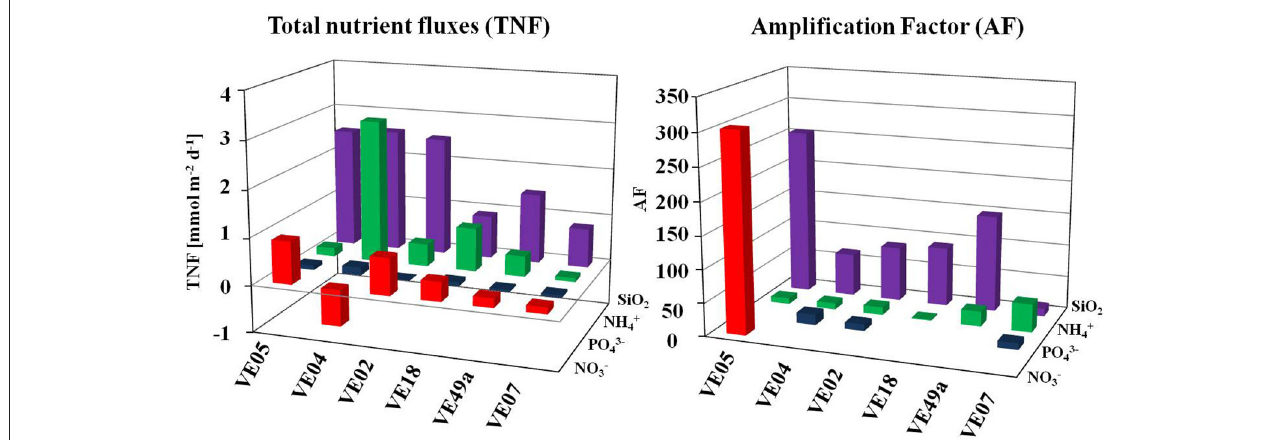
FIGURE 7 | Overview of the proportional occurrence and distribution of functional groups of macrozoobenthos at the six chamber lander incubation stations. The sizes of the pie charts reflect the total individual abundances at the stations, given in Table 1 .